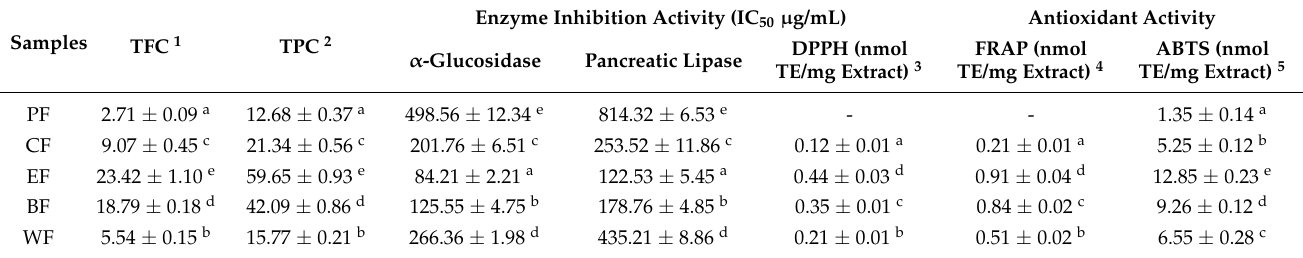
Table 1. Total phenolics content, total flavonoids content, enzyme inhibitory, and antioxidant activities of five fractions from Vaccinium